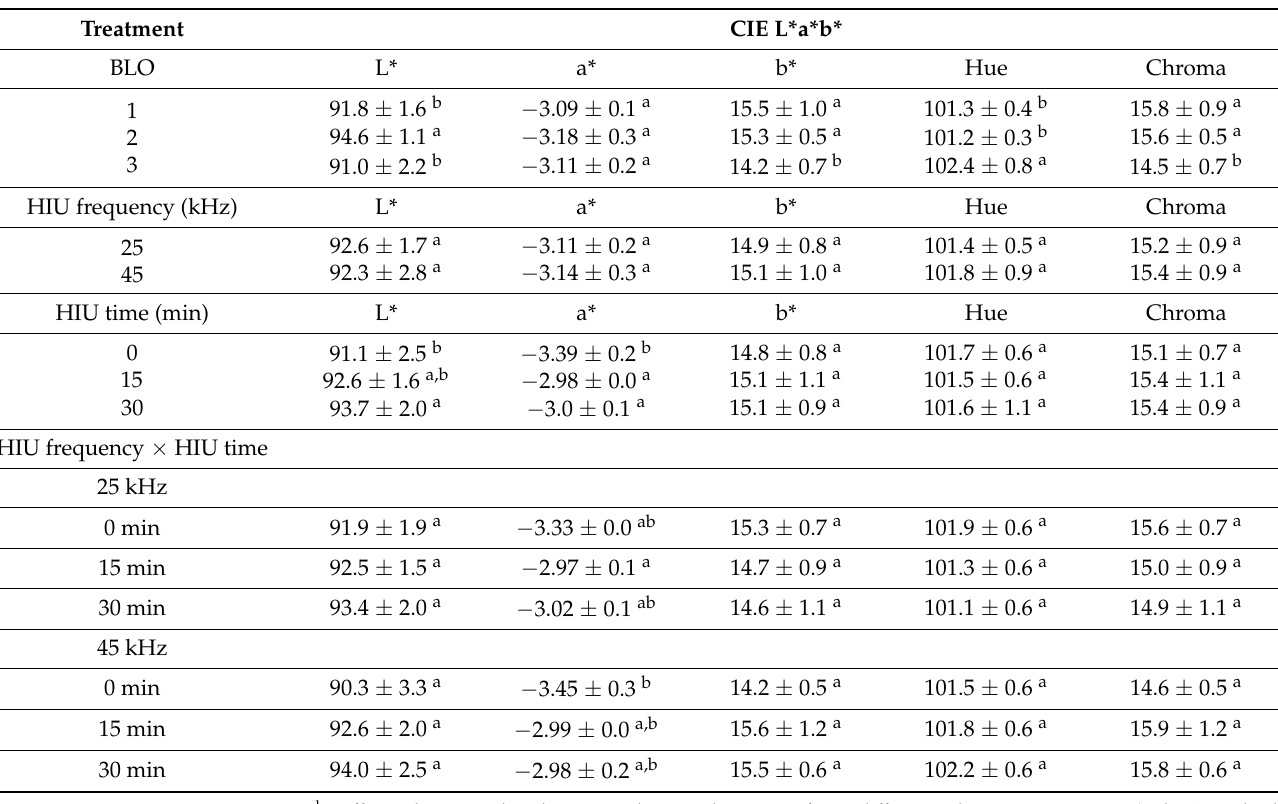
Figure 2. Images of Oaxaca cheese showing differences in appearance ( a ) and in the formation of strings or “threads” ( b ) due to the effect of ultrasound treatment (0, 15, and 30 min of HIU, 25 or 45 kHz, left to right and top to bottom); stretched ( c ) and ball forming or molded ( d ). Table 2. Effects of blocks (BLO), HIU (high-intensity ultrasound) frequency, HIU applied time and HIU frequency × HIU applied time on fresh raw milk on the color space CIE L* (lightness) a* (greenness) b* (yellowness) of Oaxaca cheese.